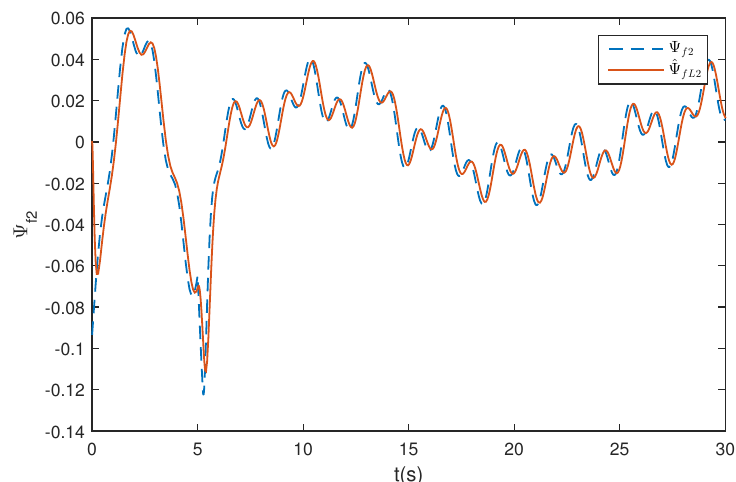
Figure 17. Estimation of Ψ f 1 using LESO.